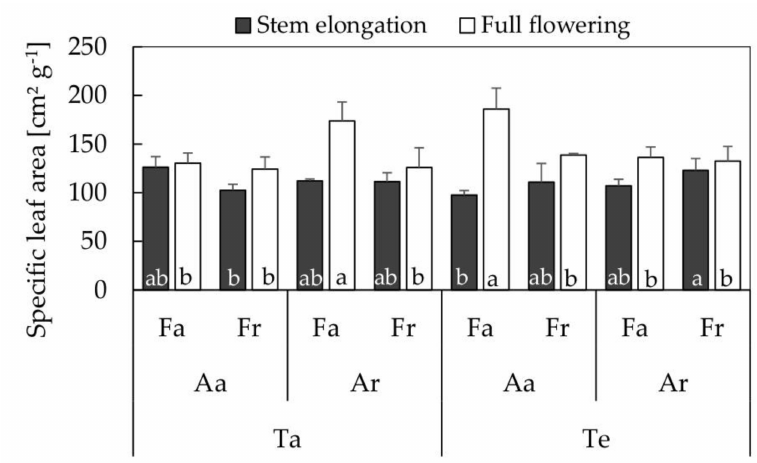
Figure 5. Specific leaf area (SLA) of OSR measured at stem elongation and full flowering. Data are means ± standard deviations across four replicates ( n = 4). Means with the same letter indicate a non-significant di ff erence between these means based on Fishers LSD test. The data originate from OSR covered by roofs. E ff ects of the roofing are mentioned in the text and therefore data of OSR planted under roofs are compared with OSR planted without